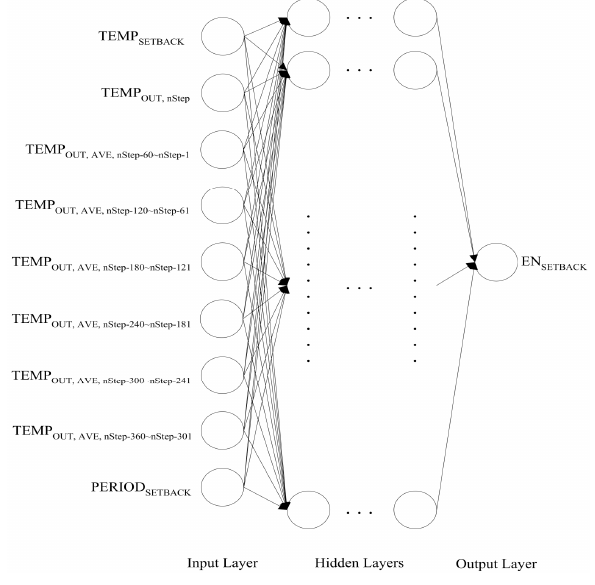
Figure 2. Structure of the initial ANN